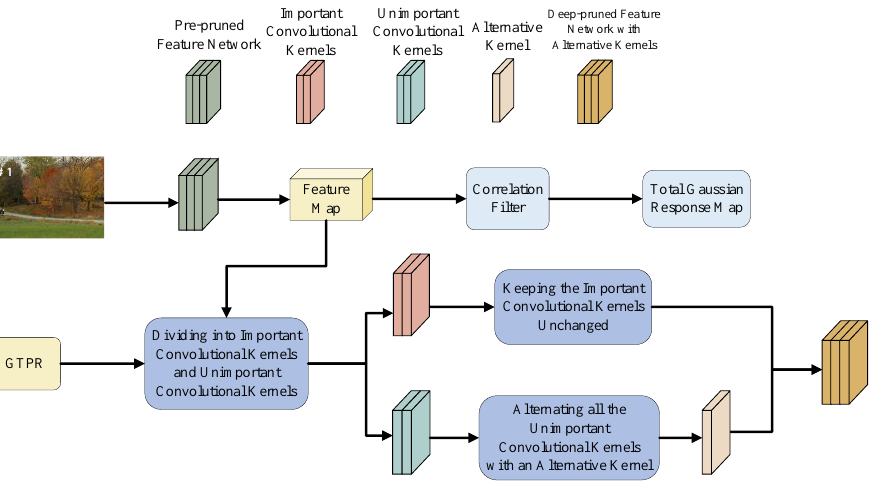
Figure 4. Definition and initialization of alternative convolutional kernels, and secondary pruning of deep feature extraction network. ( #𝑖 indicates the 𝑖 𝑡ℎ picture in the video sequence).